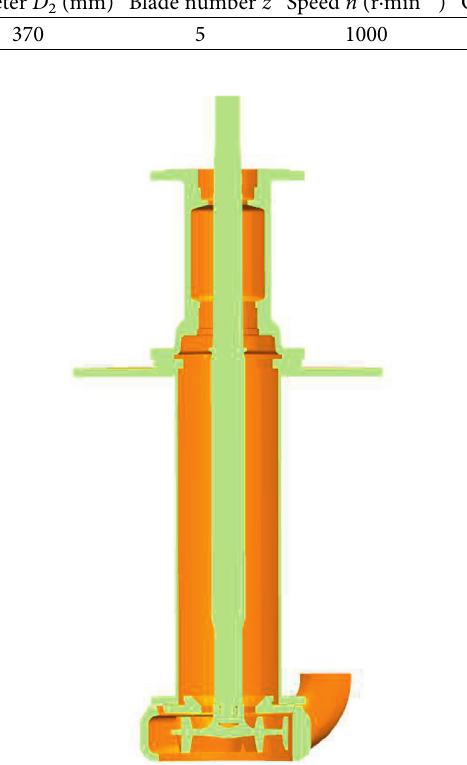
Figure 2: Sump pump assembly drawing. Table 2: Pump shaft lengths for various D.